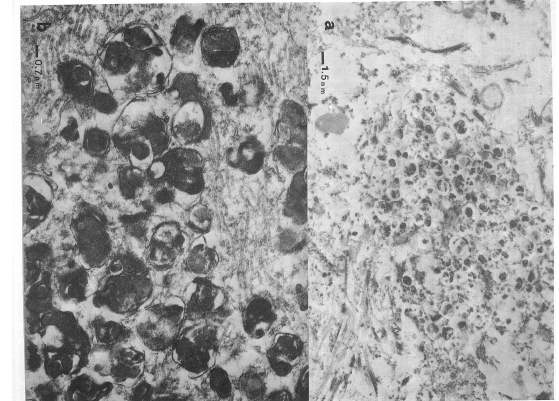
Figure 10: Microscopy images showing the structure of senile A β plaques. a) Brain tissue observed in the electron microscope